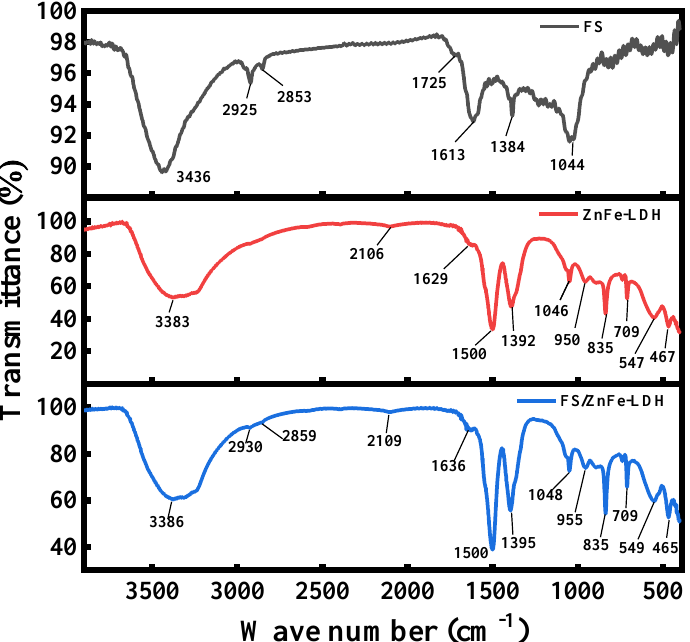
Figure 1. Fourier transform infrared spectrometer(FTIR) spectra of Zinc-iron hydrotalcite(ZnFe-LDH), FS/ZnFe-LDH, and F-T diesel soot (F-T DS, FS).